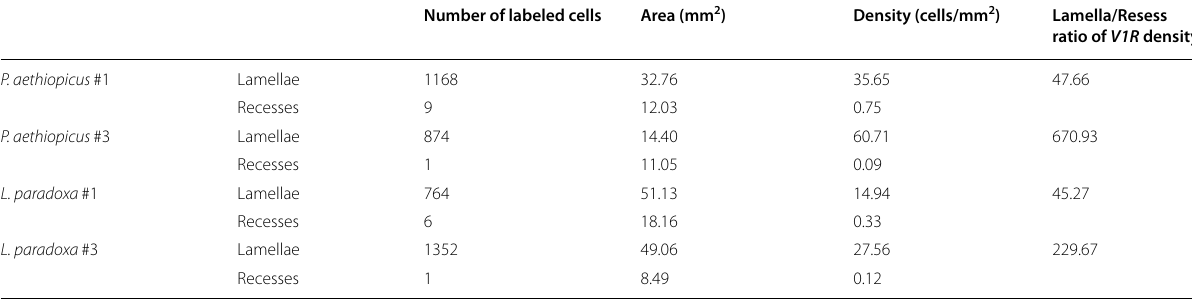
Table 5 Density of cells labeled by mixed probes for V1Rs